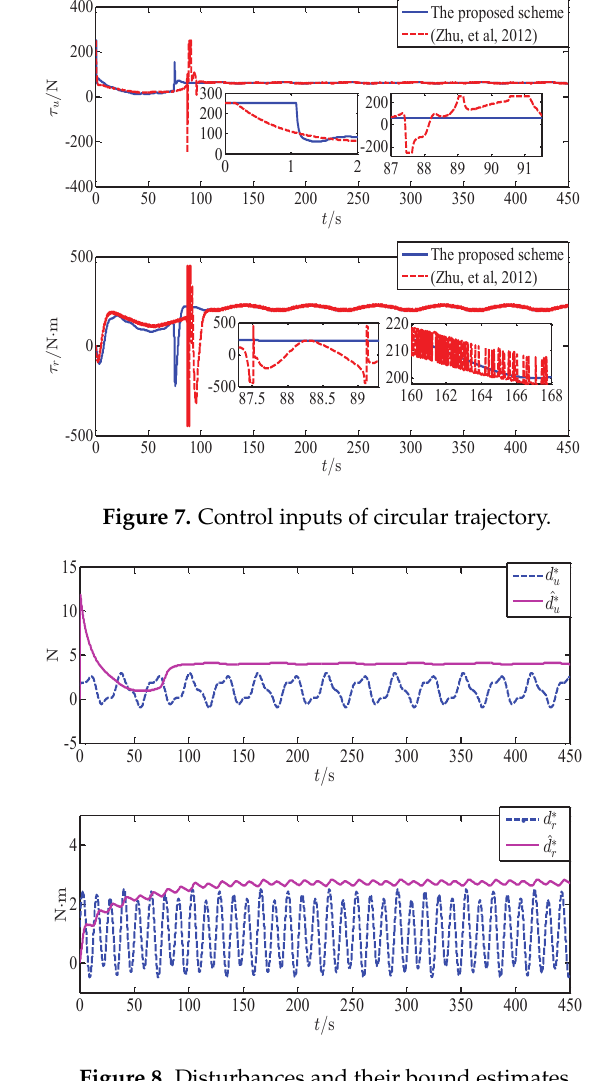
Figure 8. Disturbances and their bound